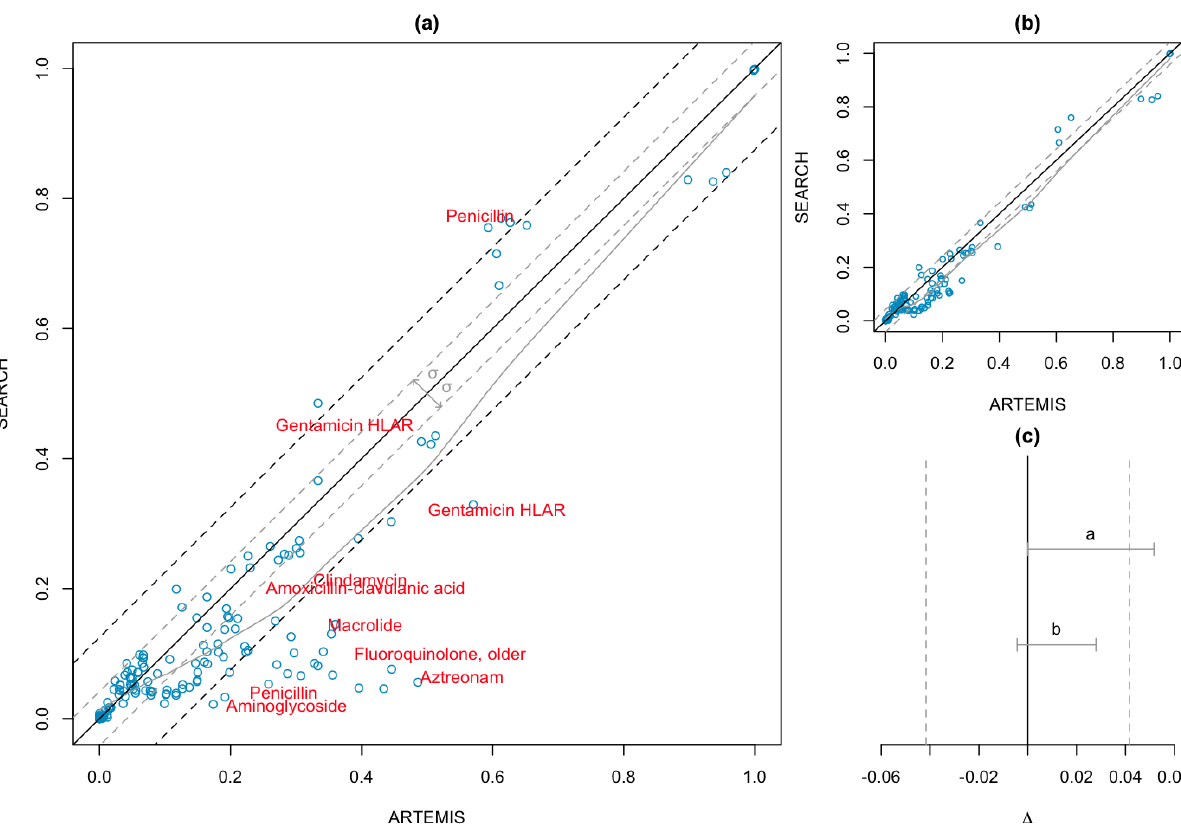
Figure 8. Antimicrobial Resistance Trend Monitoring System (ARTEMIS) vs Sentinel Surveillance of Antibiotic Resistance in Switzerland (SEARCH). (a) Resistance rates (n = 153). Black line indicates exact match (100% equivalence). Gray line indicates best fit. Gray dashed lines indicate Δ = ±0.042. (b) Resistance rates without outliers (n = 143). (c) Gray vertical dashed lines indicate similarity region Δ . Gray horizontal bars indicate two